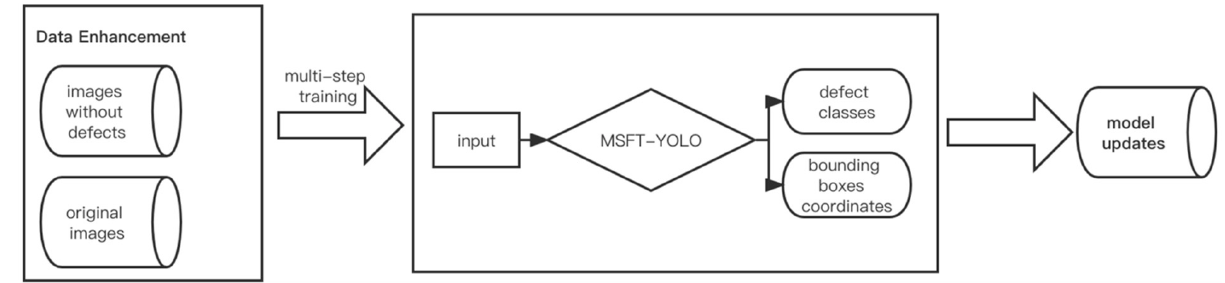
Figure 5. The flow diagram of multi-step training method.